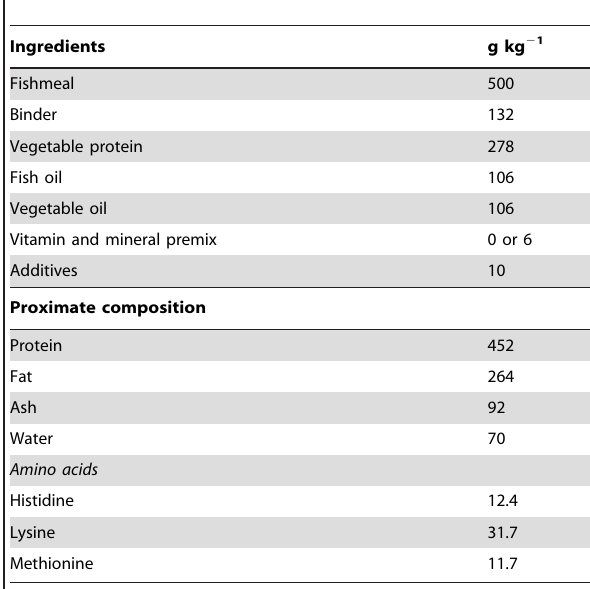
Table 1. The experimental basal feed recipe (g kg 2 1 ) and macronutrient composition in the experimental